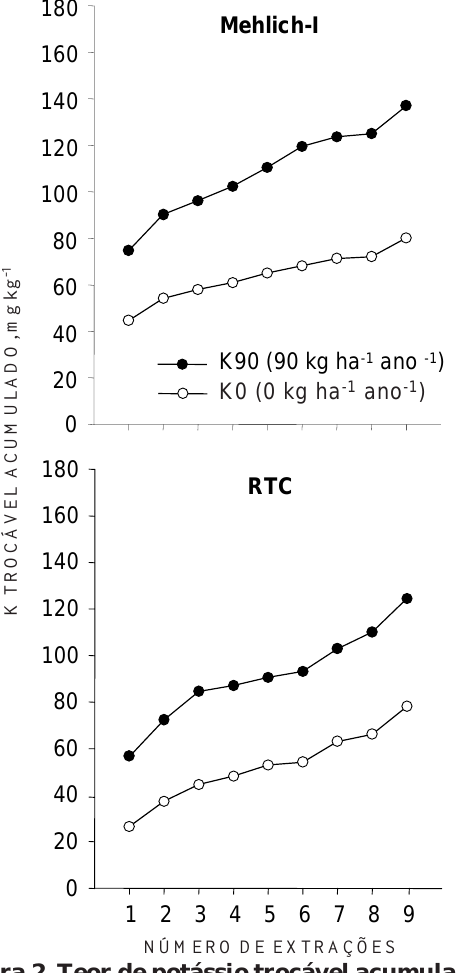
Figura 2. Teor de potássio trocável acumulado por extrações sucessivas pelos extratores de Mehlich-1 e resina trocadora de cátions (RTC), em amostras de solo (0–10 cm) que não receberam (K0) e que receberam potássio (K90) via fertilização durante 11